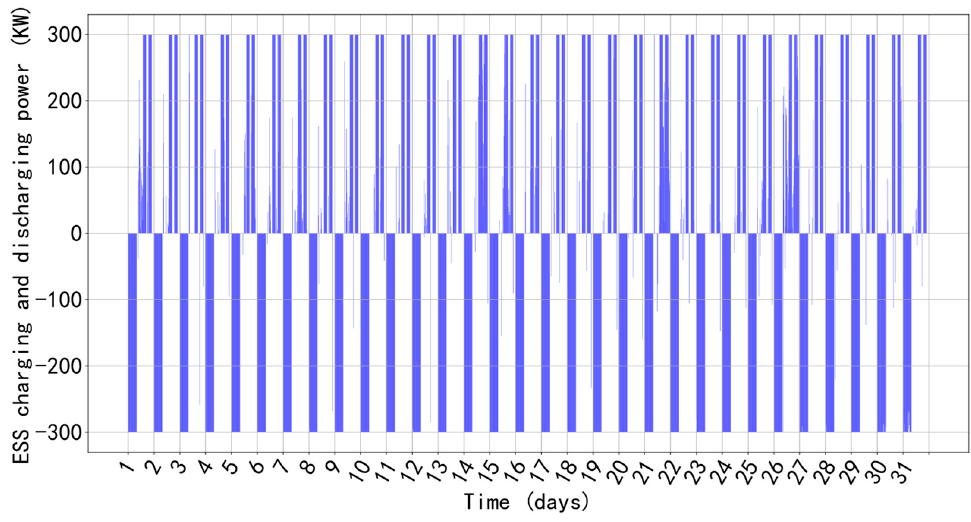
Figure 11. Monthly ESS charging and discharging power.